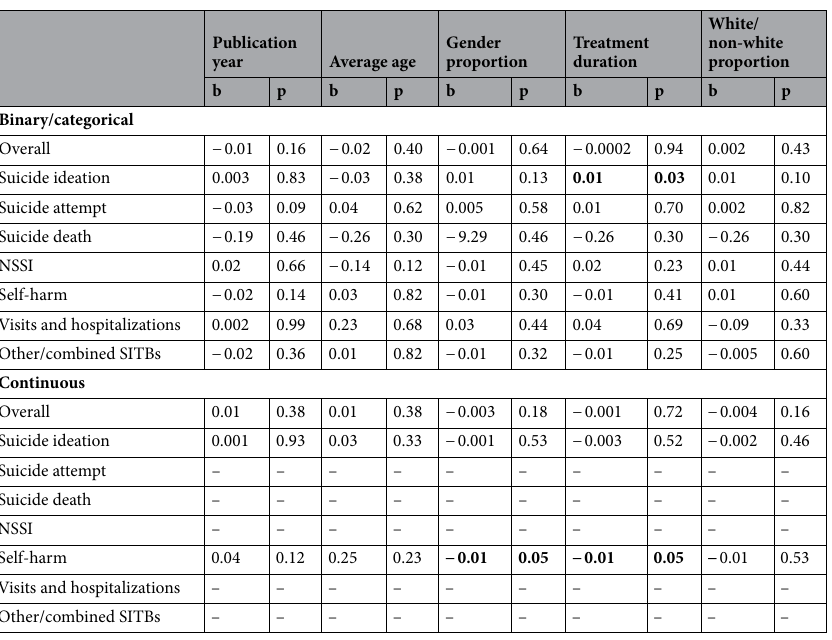
Table 3. Meta-regression analyses for continuous moderators across SITB outcomes. Estimates were not reported for analyses involving fewer than five effect sizes to improve the reliability and accuracy of estimates; b indicates the regression coefficient; dashes indicate unavailable information; boldface indicates a significant effect at p <